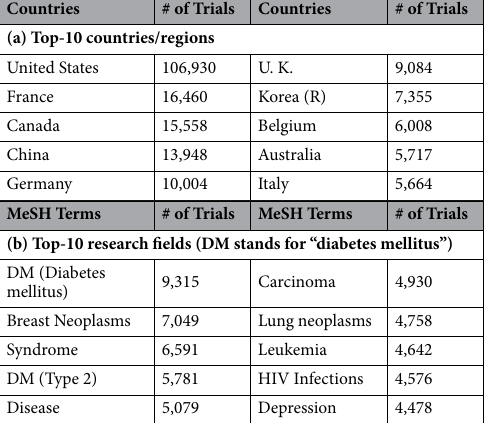
(b) Top-10 research fields (DM stands for “diabetes